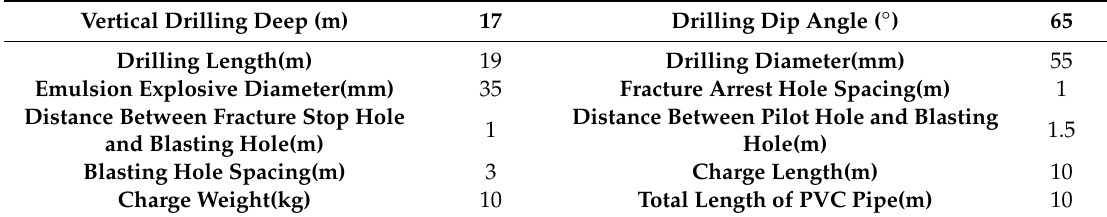
Table 4. Non-penetrating directional pre-splitting blasting parameters.